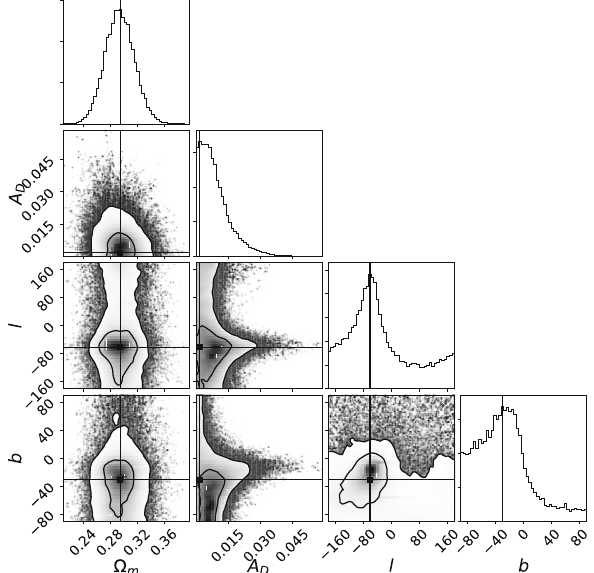
Fig. 3 The marginalized posterior distribution of the parameters in the Finslerian cosmological model from the 2015 quasar compilation and Pantheon sample. The horizontal and vertical solid black lines denote the maximum of 1-dimensional marginalized posteriors